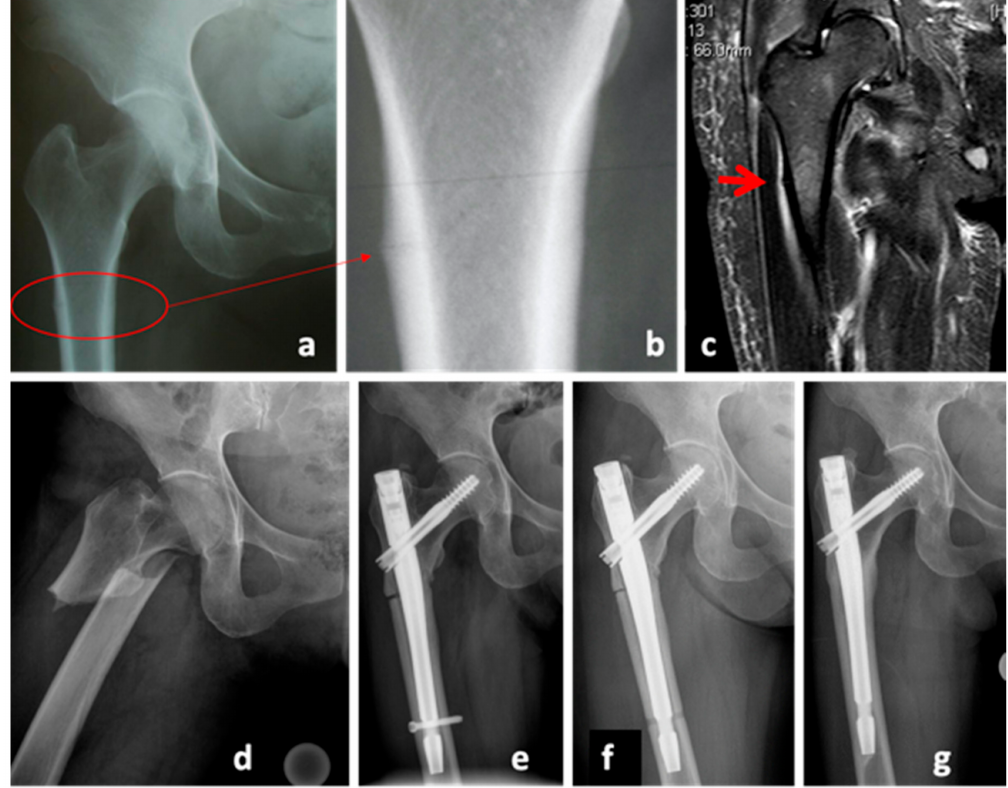
Figure 1. Case 1, X-Rays and MRI of the femur on the day of initial presentation ( a – c ) and one day later ( d ), showing the diagnosis of an atypical femoral fracture (AFF) under bisphosphonate therapy. X-ray of the hip, 7 months after trauma in the presence of a delayed union ( e ), after nail dynamization ( f ), and at the end of the teriparatide therapy ( g ), 31 months after